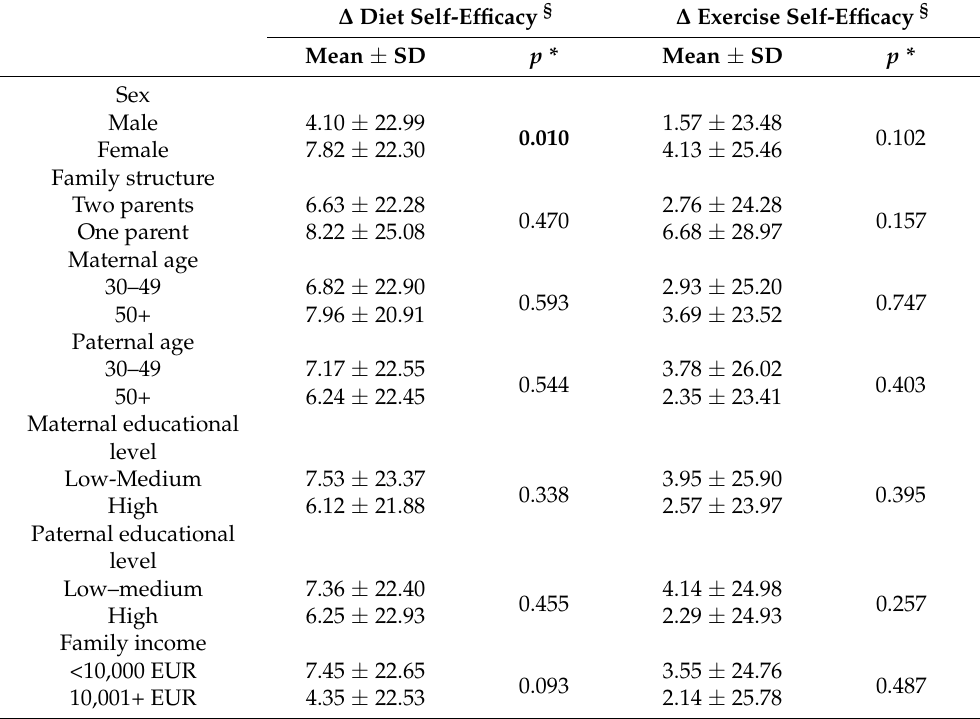
Table 2. Sociodemographic characteristics of adolescents according to differences in diet and exercise self-efficacy scores. ∆ Diet Self-Efficacy § ∆ Exercise Self-Efficacy §